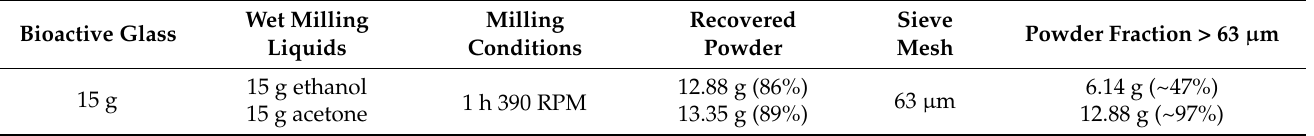
Table 1. Effects of wet milling liquids on milling